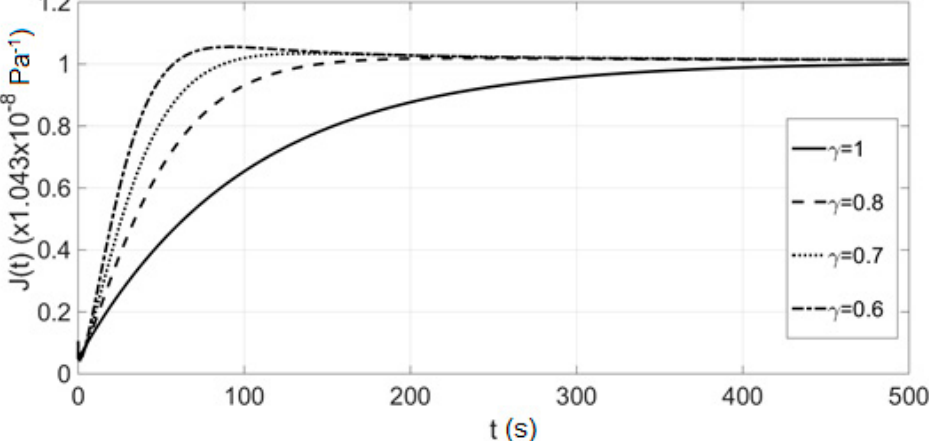
Figure 9. Variation of the creep compliance versus time for γ = 1, 0.8, 0.7, 0.6 in the initial space.